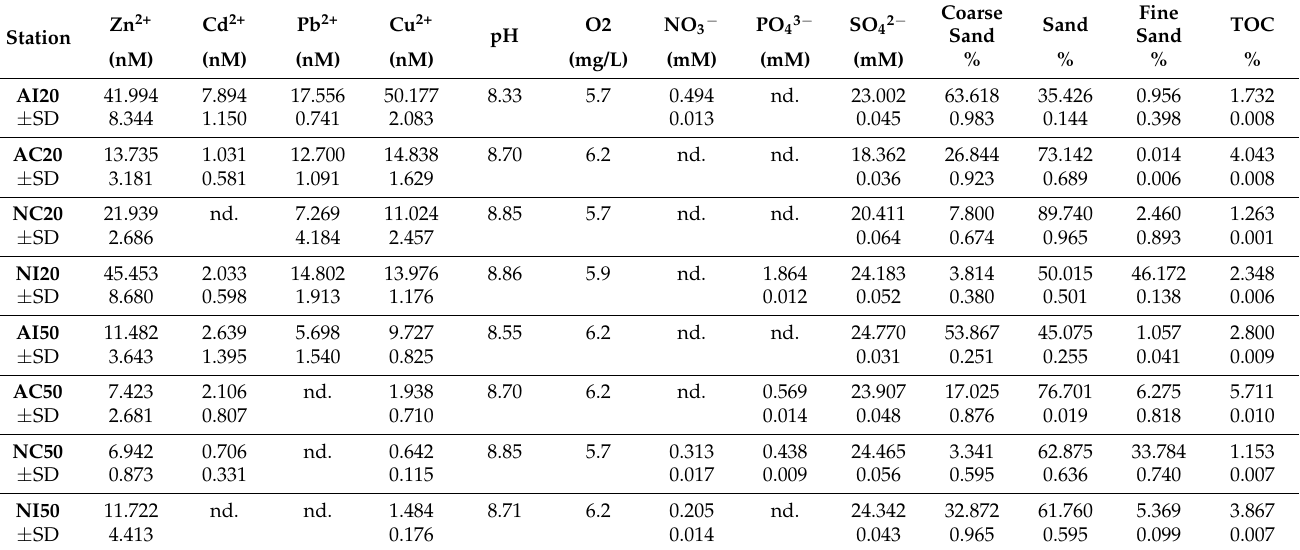
Table 1. Environmental conditions of each station. Data were expressed as nanomoles (nM), milligrams/liter (mg/L), or as percentage of total sample (%); nd. refers to no detectable concentration. Standard deviation (SD) of each variable is also